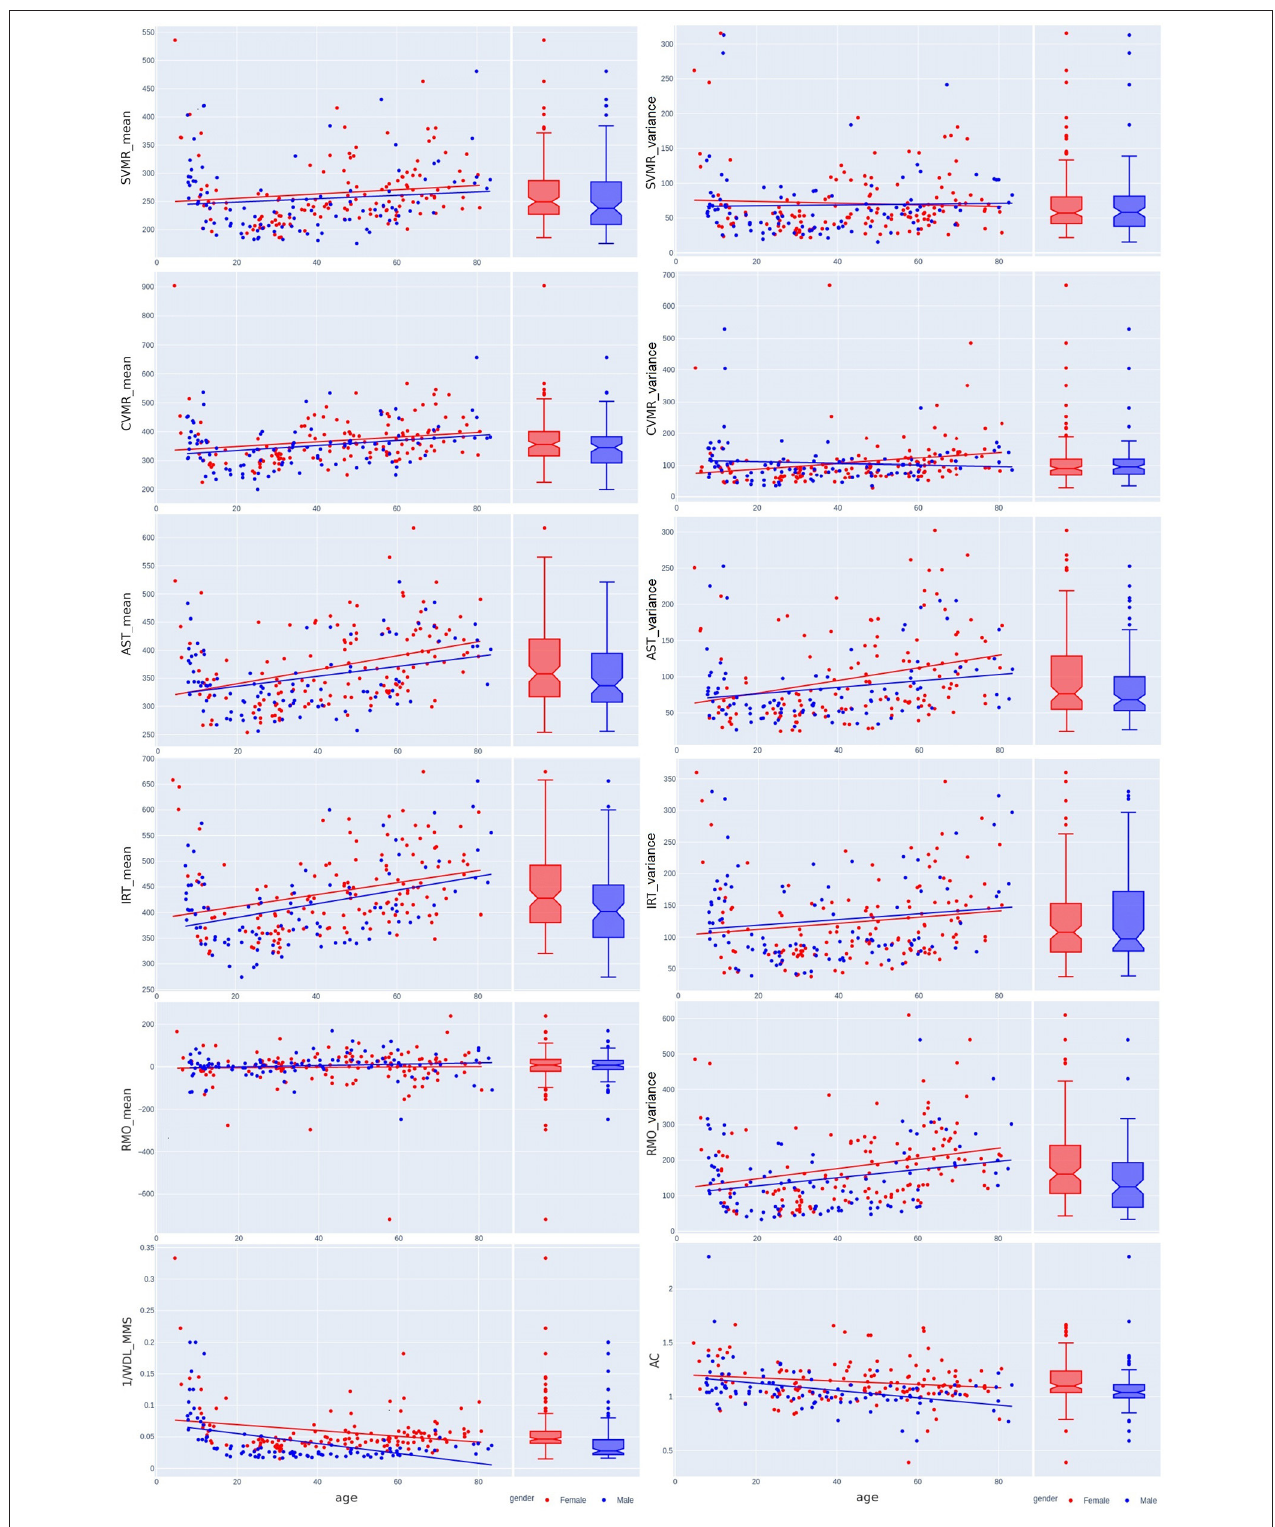
FIGURE 6 | Sex-related differences in reaction time attributes and results of wrist dynamometry.